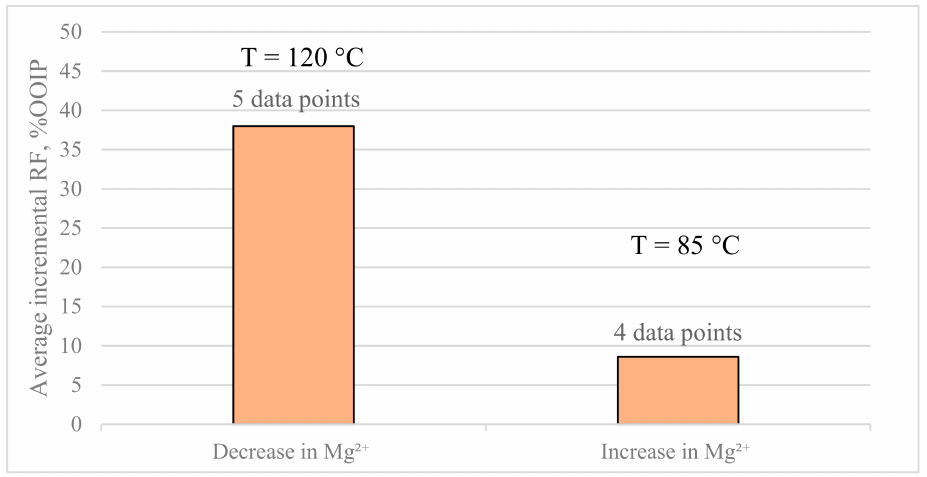
Figure 7. Average incremental RF vs. Mg 2+ concentration change.